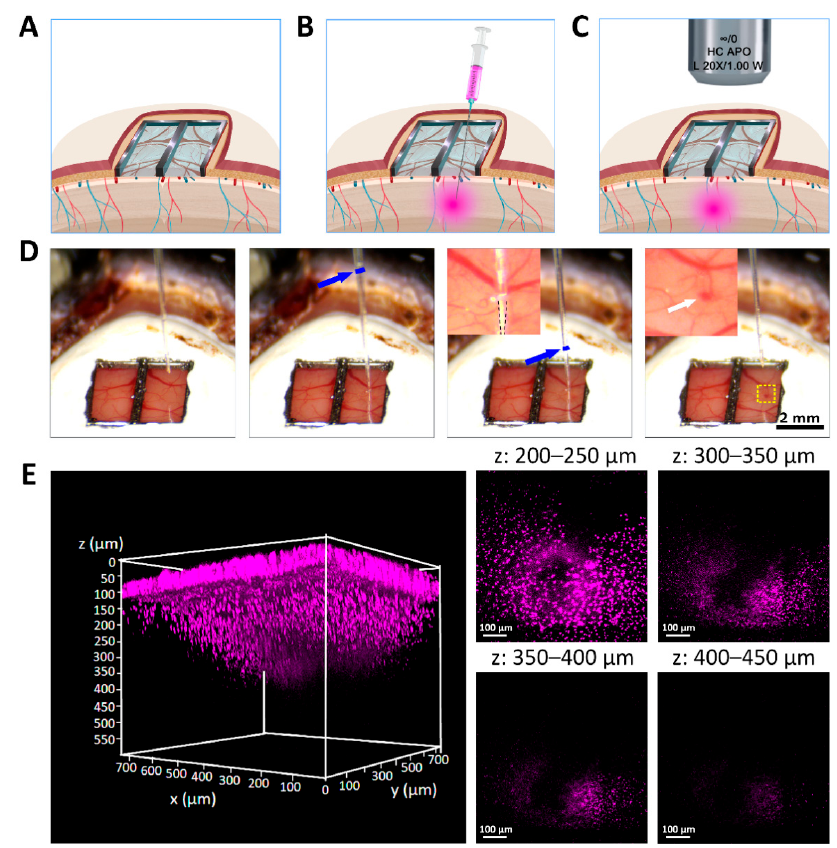
Figure 7. Dye injection of Hoechst 33258 and in vivo two-photon imaging through Ti-PDMS cranial window. ( A – C ) Schematic diagram of single site injection and imaging through Ti-PDMS cranial window. ( D ) Sequential images of the glass pipette placement and removal performed in 10 weeks post-implantation. A glass pipette was inserted into the brain tissue directly through the PDMS cover to avoid major vasculature. Hoechst 33258 (10 µg ml − 1 , 0.2 µL, 0.1 µL min − 1 ) was injected into the brain. The blue arrow in the second and third images marked the liquid level. The black dashed lines inserted in the third image outlined the tip of the glass pipette. The yellow dashed line in the fourth image marked the injection site. The image inserted in the fourth image showed the enlarged view of the injection site, which was marked by the white arrow. ( E ) Two-photon imaging for Hoechst 33258 was possible up to 450 µm in z-depth.